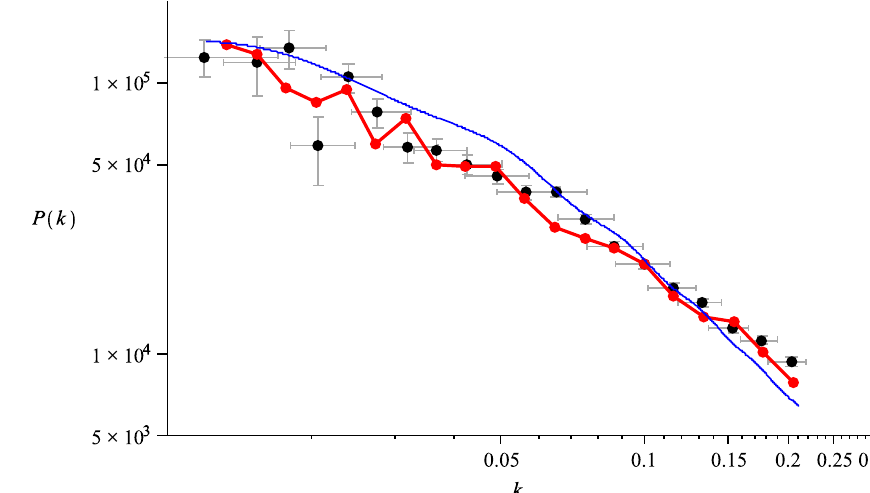
Fig. 2 After applying the appropriate window function, MOG (thick red line) shows agreement with the luminous red galaxy survey mass power spectrum data. The MOG fit to the data is comparable to the CDM prediction (thin blue line) [25,26]